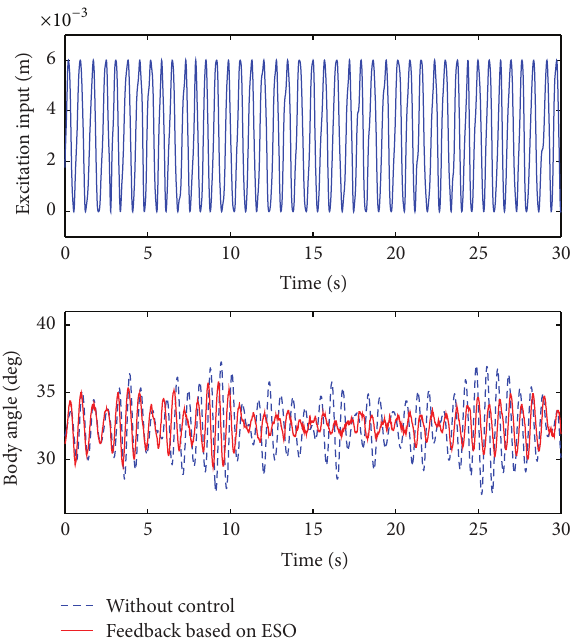
Figure 13: Random excitement input experimental results.